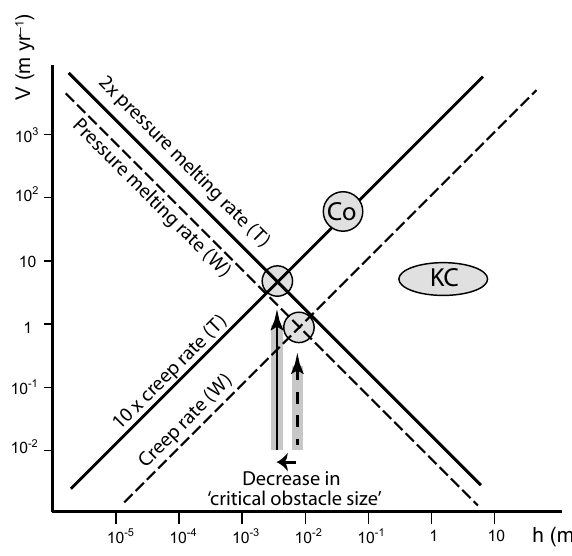
Figure 6. Sliding velocity due to pressure melting and enhanced creep (logarithmic scale) as a function of height of obstacle (Weert- man, 1957). Intersection represents the critical obstacle size. W is the velocities following Weertman; T is the velocities in temperate ice; KC and Co are velocity and critical obstacle size of estimates of Kamb and LaChapelle (1964) and Cohen et al. (2000)